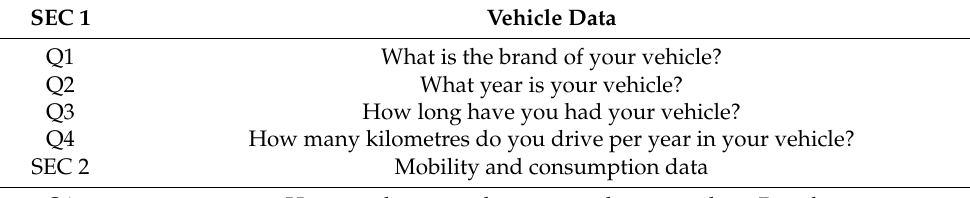
Table A1. Driver survey